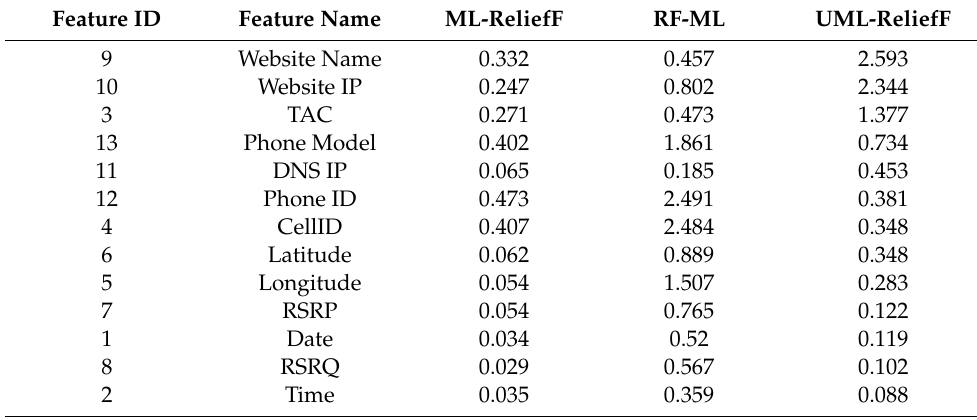
Table 1. Comparison of feature weights of the feature selection (FS) algorithms.